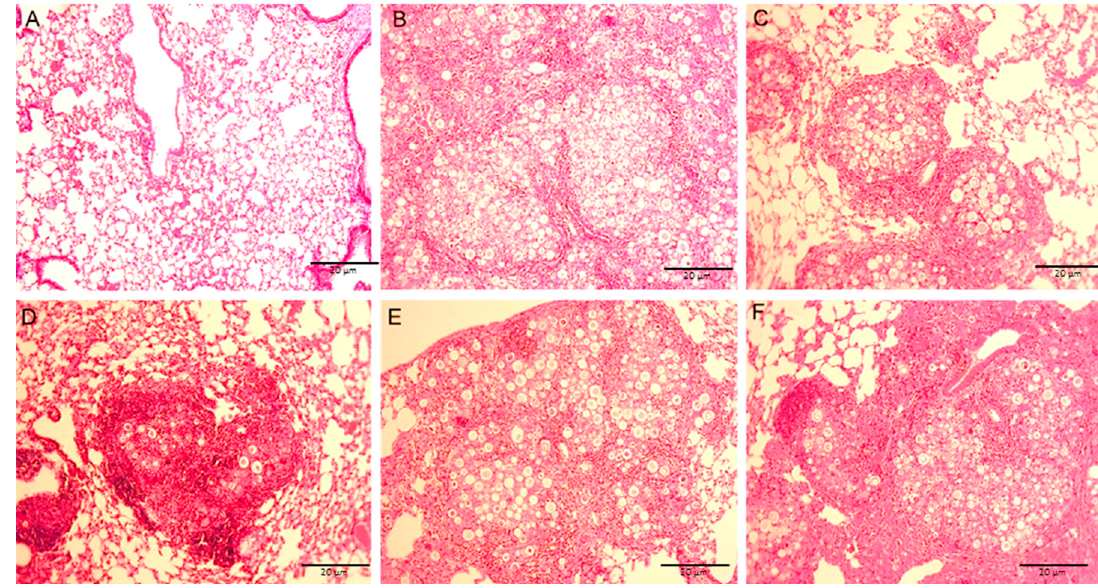
Figure 4. Photomicrographs of pulmonary tissues from C57BL/6 mice with or without P. brasiliensis infection. The lung sections were stained with Hematoxylin and Eosin to analyze the presence of inflammation. Uninfected lung tissue ( A ) is presented for comparison with P. brasiliensis infected lungs from mice that received PBS only ( B ), treated with DDA/TDB alone ( C ), or vaccinated with DDA: DDA/TDB 250/50 µg/P10 20 µg ( D ) DDA/TDB 312.5/62.5 µg/P10 20 µg ( E ) or DDA/TDB 500/100 µg/P10 20 µg ( F ). (10× magnification).